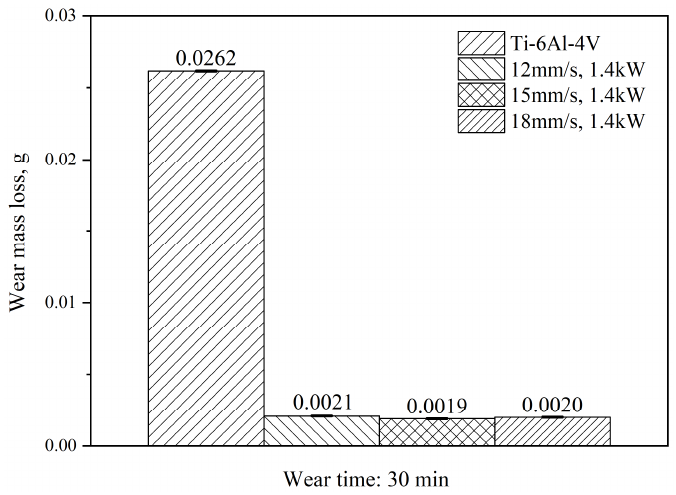
Figure 9. The wear mass loss of the substrate and coatings under different scanning speeds.